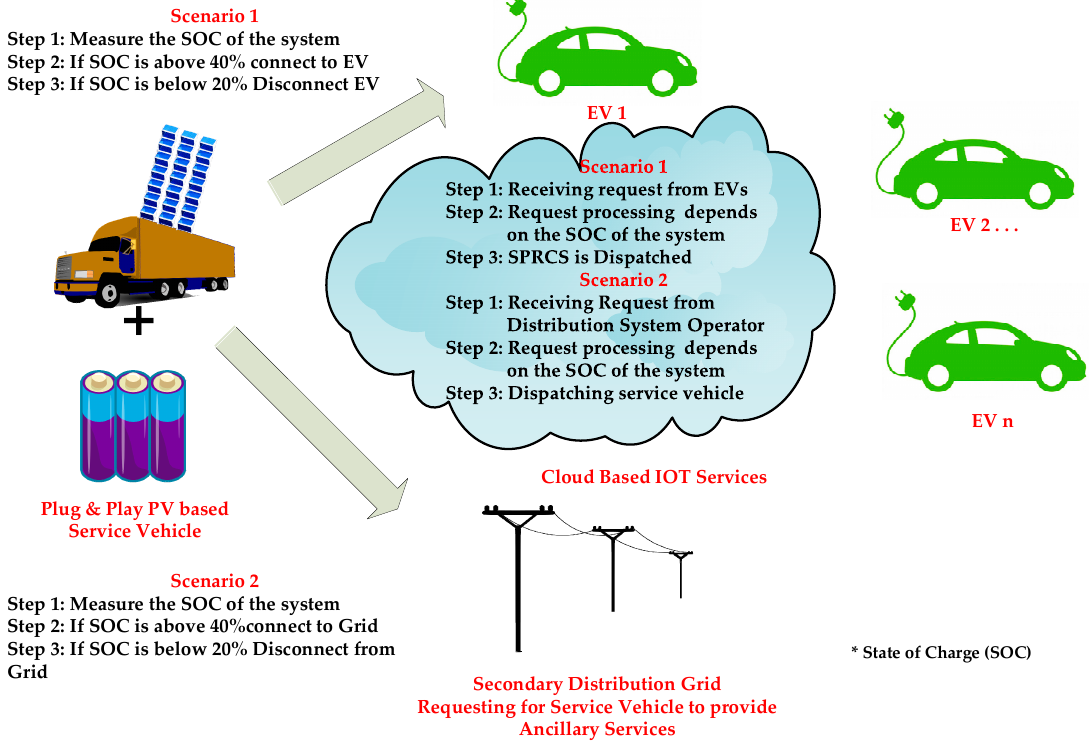
Figure 1. Proposed plug and play solar photovoltaic rapid charging station.